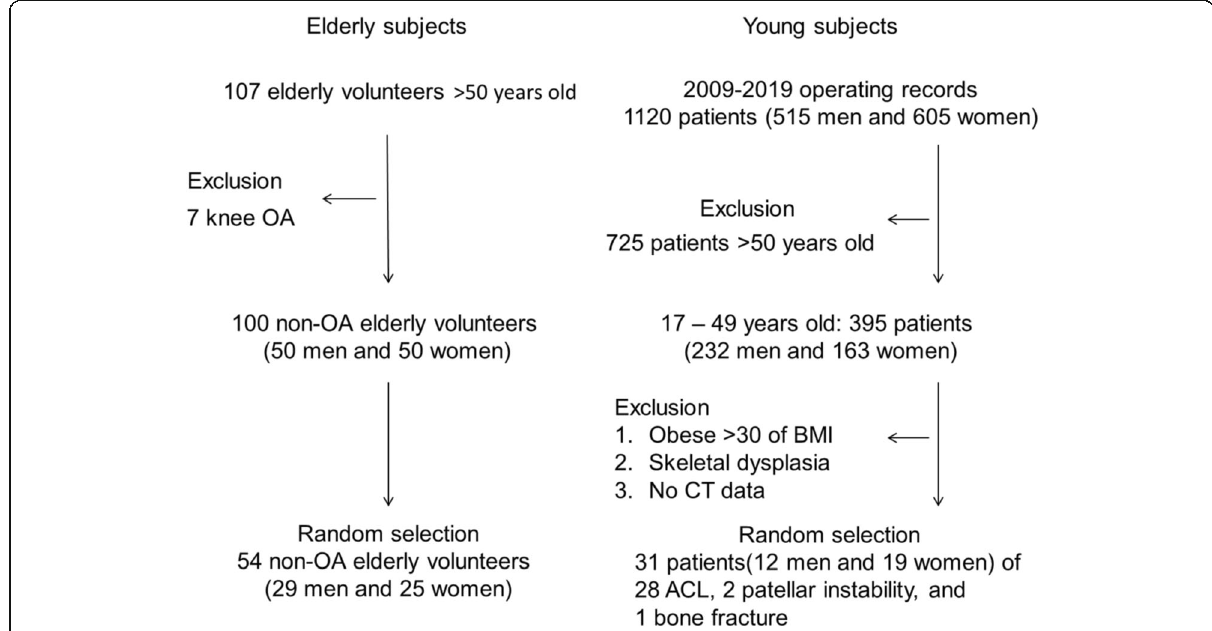
Fig. 3 Inclusion and exclusion criteria of the subjects. OA: osteoarthritis, BMI: body mass index, ACL: anterior cruciate